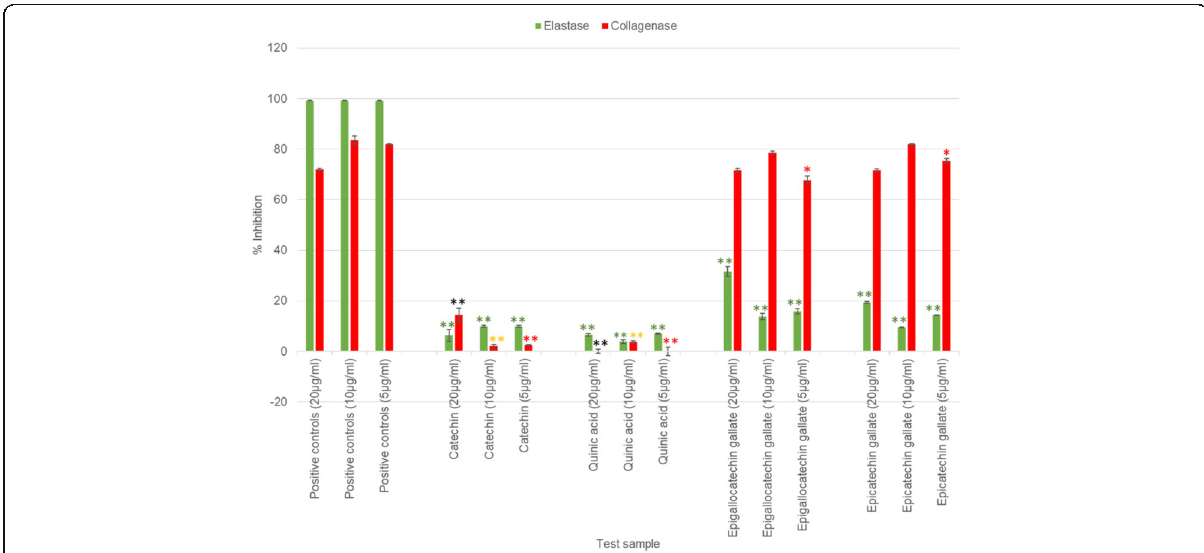
Fig. 4 Collagenase and elastase inhibition activities of major compounds identified in Marula stem ethanol extract at 20, 10 and 5 μ g/ml. (Error bars represent SEM, with n = 3). = P < 0.05, = P < 0.01 represent a significant difference with EDTA at 5 μ g/ml, = P < 0.05, = P < 0.01 represent a significant difference with EDTA at 10 μ g/ml, = P < 0.05, = P < 0.01 represent a significant difference with EDTA at 20 μ g/ml, and = P < 0.05, = P < 0.01 represents a significant difference with